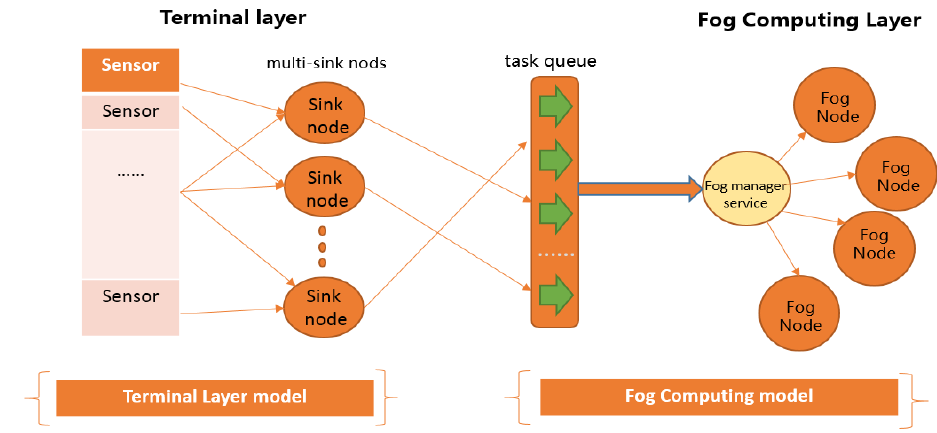
Figure 2. The architecture of the internet of things-based fog computing model